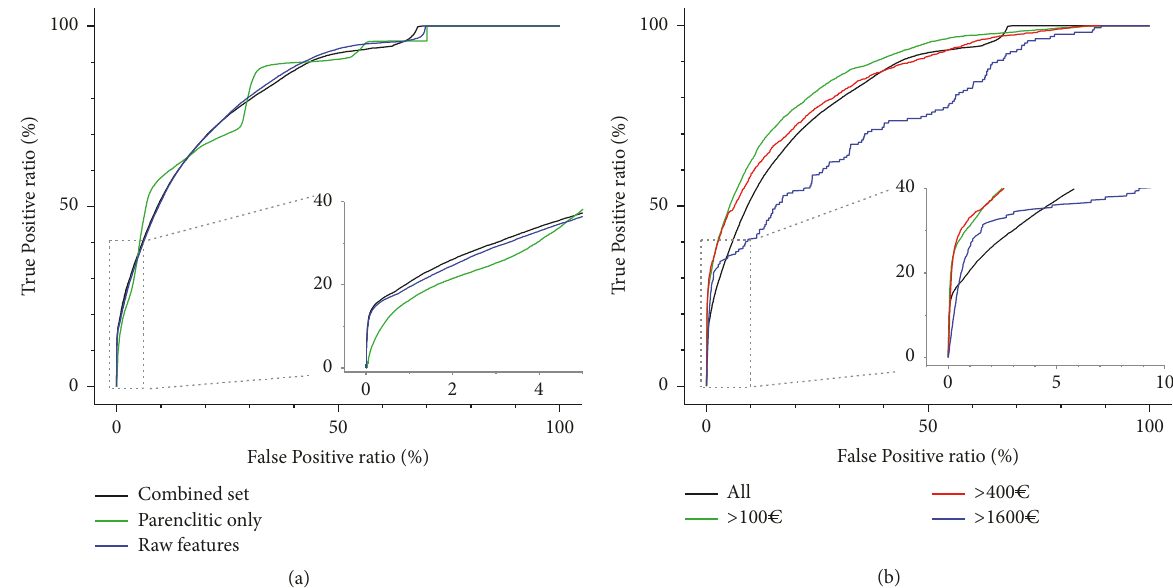
Figure 3: (a) ROC curves of the classification, corresponding to the use of the raw features alone (blue line), of the parenclitic features (green line), and of the combined sets (black line). (b) ROC curves, obtained through the combined data set, as a function of the transaction